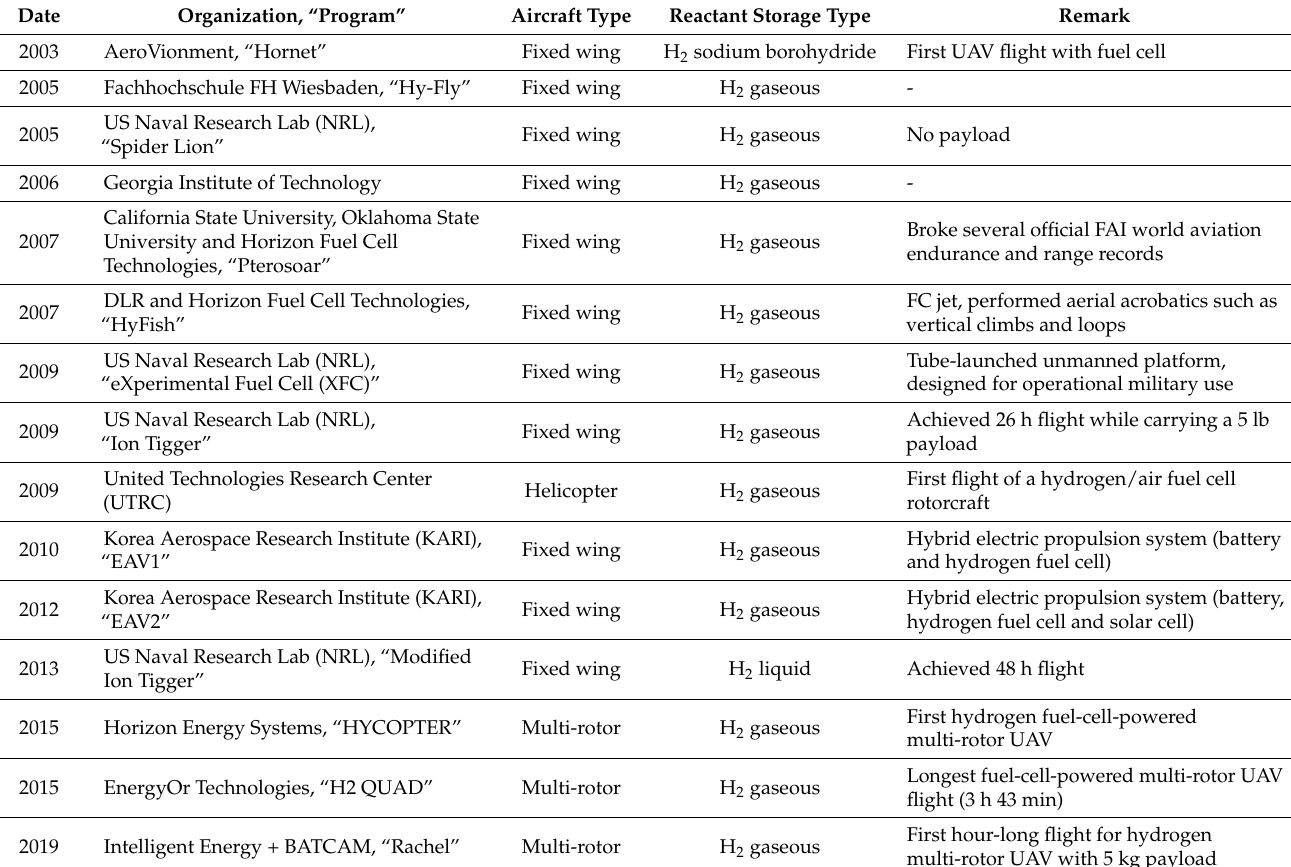
Table 4. Examples of FC-powered